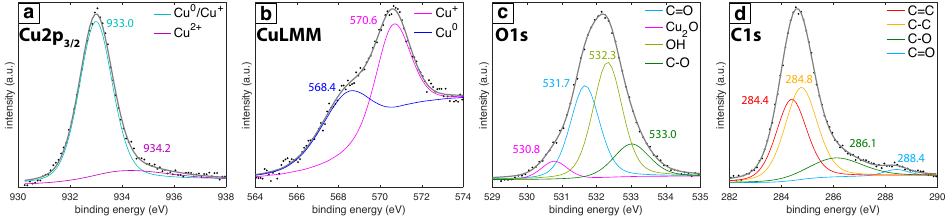
Figure 3. XPS spectra of ( a ) Cu2p 3/2 , ( b ) CuLMM, ( c ) O1s and ( d ) C1s regions with fitted peaks for 24 h